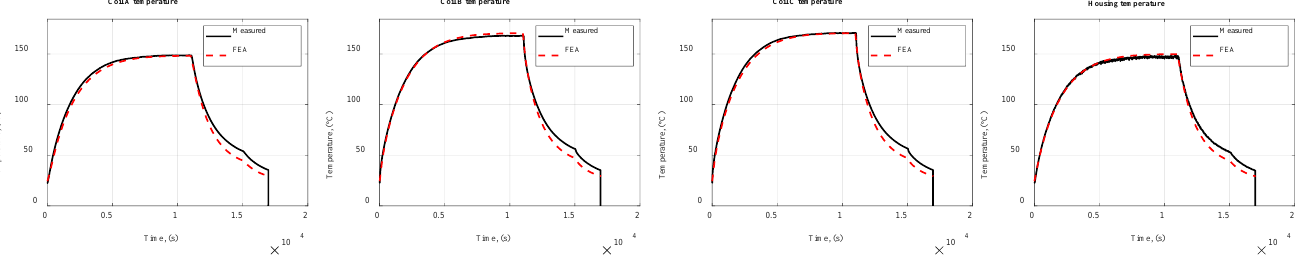
Figure 14. Measured temperatures and FEA-computed temperatures for the short-time pulse test in configuration A.